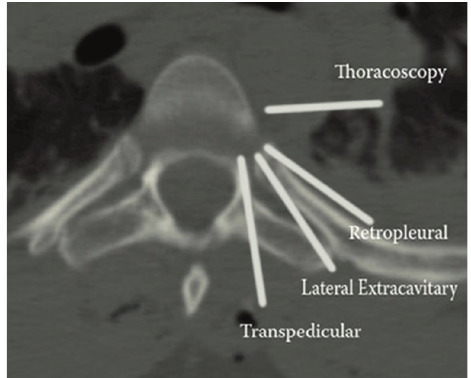
Figure 5: Axial CT image in midthoracic spine demonstrating the trajectory used in the various minimally invasive approaches for